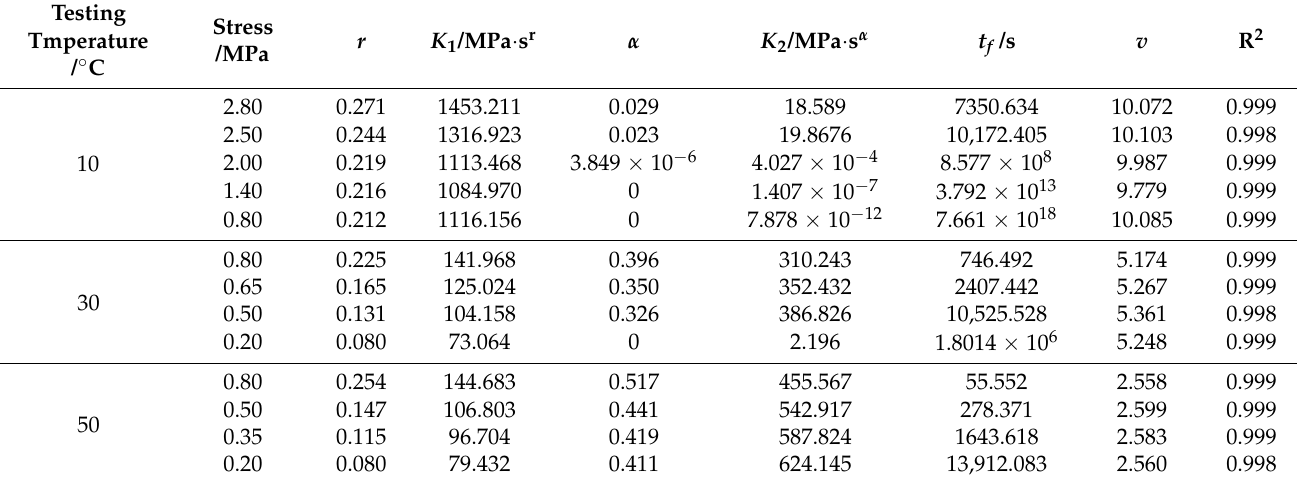
Table 4. The parameters of the proposed constitutive